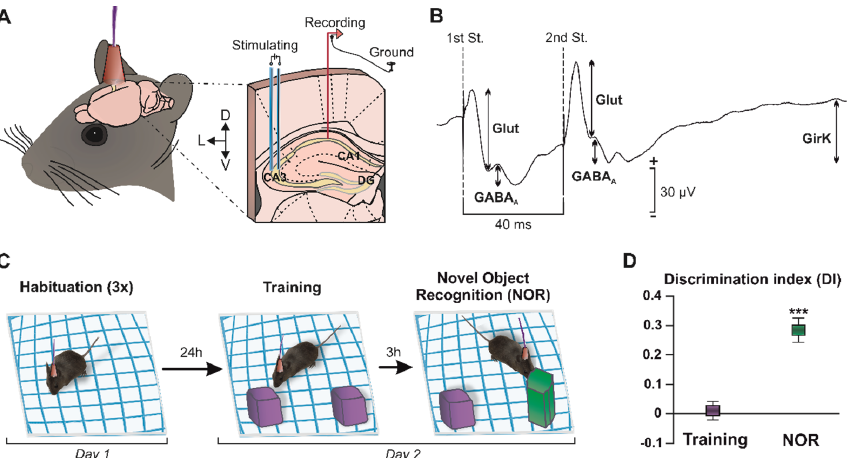
Figure 1. Experimental design. ( A ) The picture illustrates how mice were prepared for chronic re- cording of fPSPs in the hippocampal CA1 region, by surgical implantation of bipolar stimulating electrodes on the right Schaffer collaterals, and bipolar recording electrodes at ipsilateral CA1. A bare silver wire was fixed to the skull as ground. ( B ) Representation of the fPSPs evoked in the CA1 hippocampal region after paired-pulse stimulation (40-ms interstimulus interval) at the Schaffer col- laterals. The representative recording illustrates the averaged (n = 50) profile of the postsynaptic response. For each fPSP, the maximum amplitude (peak-to-peak value, see arrows) was measured for the analysis. DG, dentate gyrus; St., stimulus; D, dorsal; L, lateral; V, ventral; and Glut, gluta- mate. ( C ) NOR task. The object recognition protocol consisted of three 5-min habituation sessions with the empty box (interval of 1.5 h between the habituations) on day 1. On day 2, two identical objects were placed (purple cubes) in the center of the box and the animals (n = 36) were allowed to explore them for 10 min (training session). Three hours later, one of the objects was replaced by a novel one (green prism) for the NOR session. ( D ) Graph representing the discrimination index (DI) during the training (two identical objects) and NOR (familiar vs. novel object) sessions. DI = 0, no discrimination between objects. *** p < 0.001 vs. DI = 0. 2.1. Development of Recognition Memory during a NOR Task Recognition memory is a cognitive capability that significantly relies on the correct functionality of the CA3–CA1 synapse in the dorsal hippocampus [31,32]. The NOR test was performed to address whether mice showed object memory retention. In the training session (Figure 1C), where two identical objects were presented to the subjects, animals (n = 36) spent a similar amount of time exploring each object, which resulted in a discrimi- nation index (DI) of approximately zero, indicating the absence of discrimination or pref- erence between objects (Figure 1D; DI = 0.01 ± 0.03, t (35) = 0.33, p = 0.746). In contrast, during the NOR session, which took place 3 h after training, mice showed a marked pref- erence for the exploration of the novel object (Figure 1D, DI = 0.28 ± 0.04, t (35) = 6.88, p < 0.001), showing that long-term memory remained intact in these animals. These results indicate that the synaptic plasticity processes underlying the establishment and consoli- dation of memories (such as LTP in the hippocampal synapse CA3–CA1) [17] were likely functional in vivo in these animals. 2.2. Object Recognition Induces Synaptic Plasticity Changes in the Hippocampus During training and NOR sessions, an external stimulator was used to apply paired pulses in the Schaffer collaterals when animals explored either of the objects. Pulses were applied in alternate exploratory events, with a minimum of 10 s between stimulation (Fig- ure 2A,B; see details in the methods section). fPSP amplitudes were measured (n = 21–22) and normalized to the training session values (100%) (Figure 2C,D). Then, a significant potentiation of the glutamatergic fEPSP evoked by the 1st stimulus during the NOR test ( t (20) = 2.11, p = 0.048) when animals explored the novel object could be detected, but not